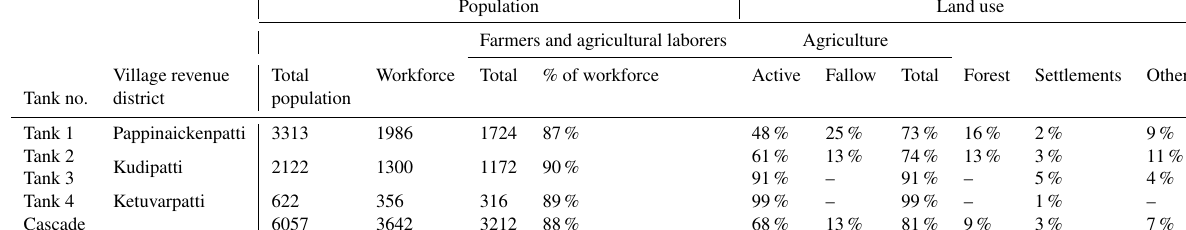
Table 1. Population and land-use data for the study cascade.